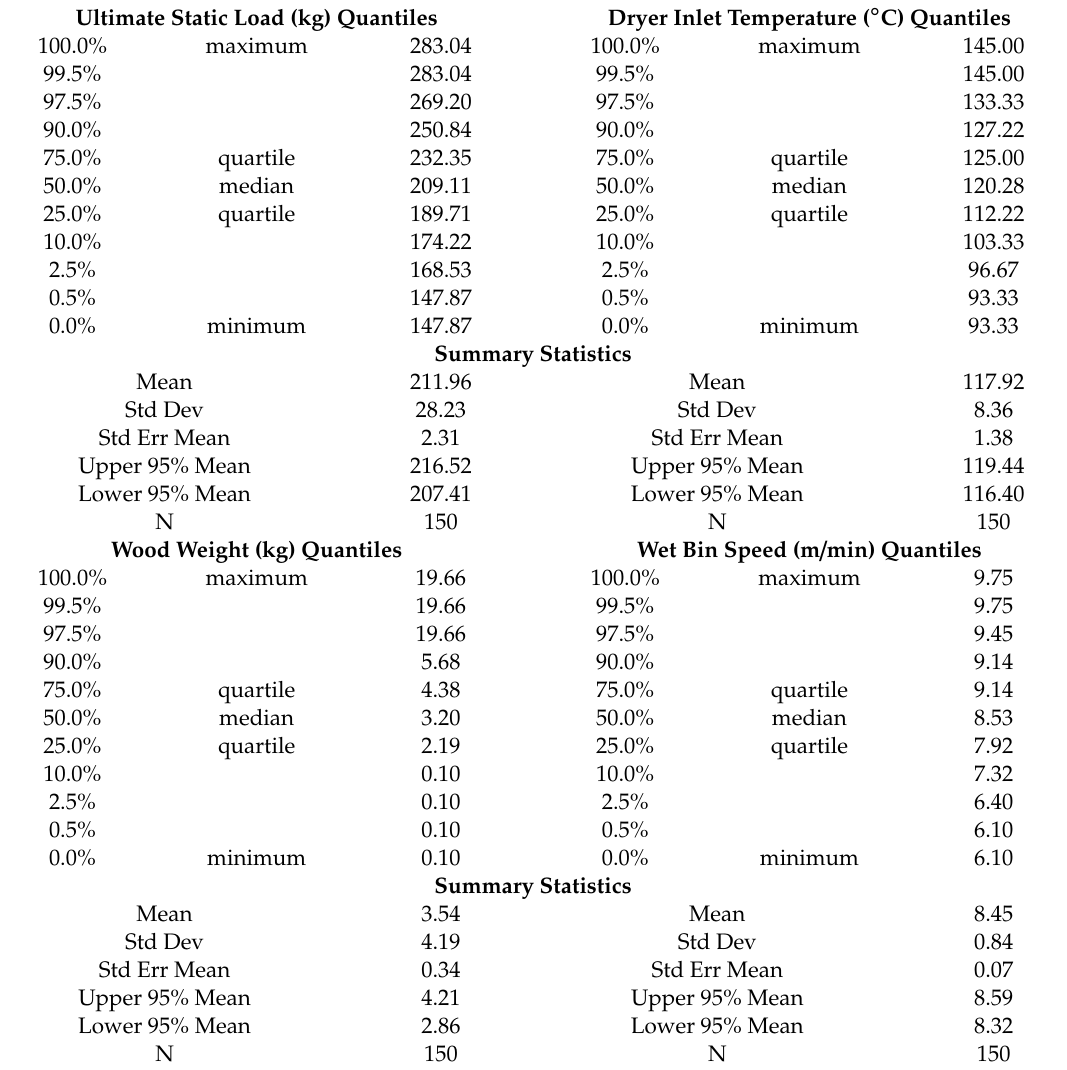
Table 6. Descriptive statistics for the dependent and independent variables in the RT model for